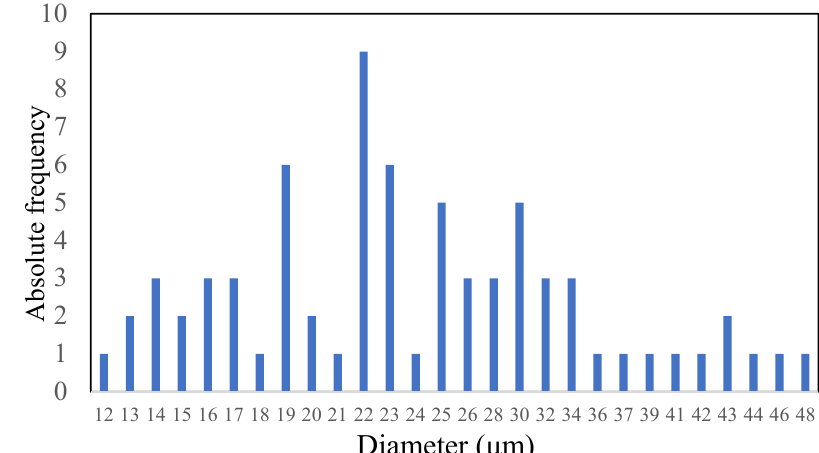
Figure 2. Microcapsule size distribution.